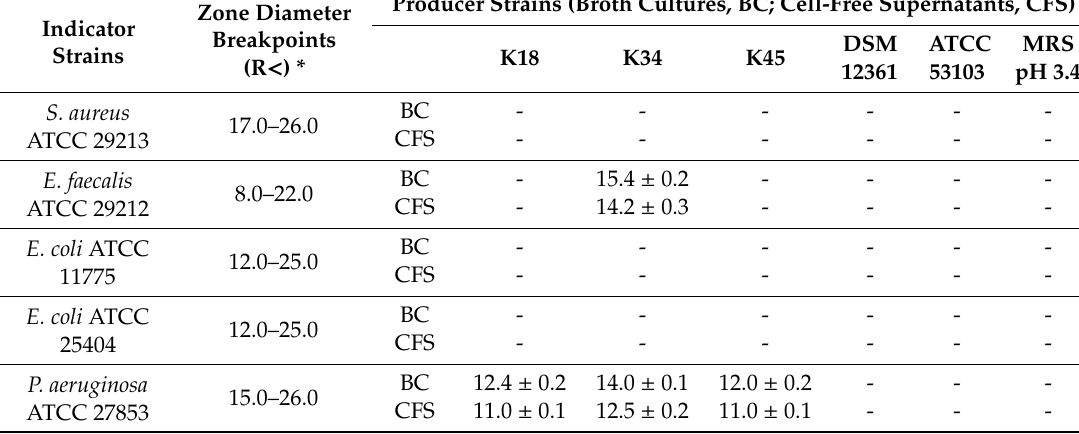
Table 4. Antimicrobial activity exerted by broth cultures (BCs) and cell-free supernatants (CFSs) of A. kunkeei K18, K34, K45 and DSM 12361 and L. rhamnosus GG ATCC 53103 (producers) against S.